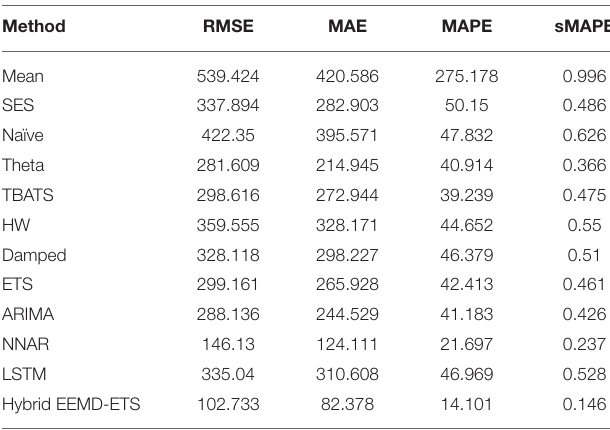
TABLE 8 | Performance comparison of different models for 7 days prediction of France’s daily deaths.